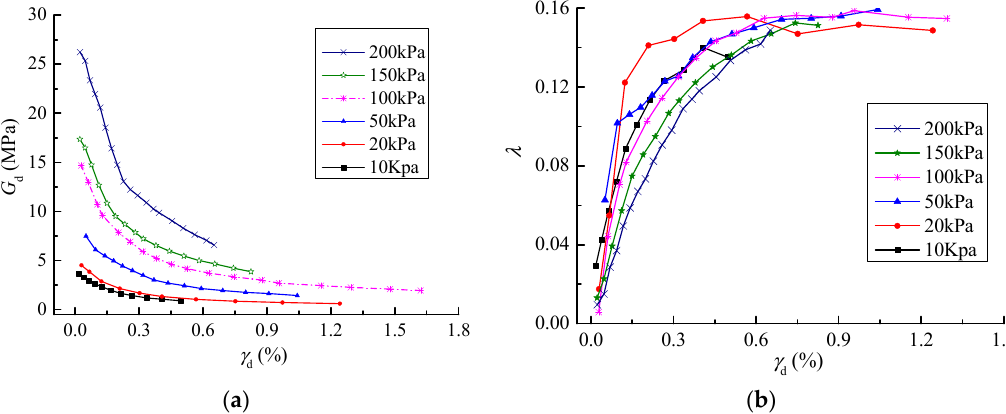
Figure 8. Shear modulus and damping ratio versus shear strain amplitude for the various confining pressure with a sawdust content of 33%. ( a ) Shear modulus versus shear strain amplitude; ( b ) damping ratio versus shear strain amplitude.